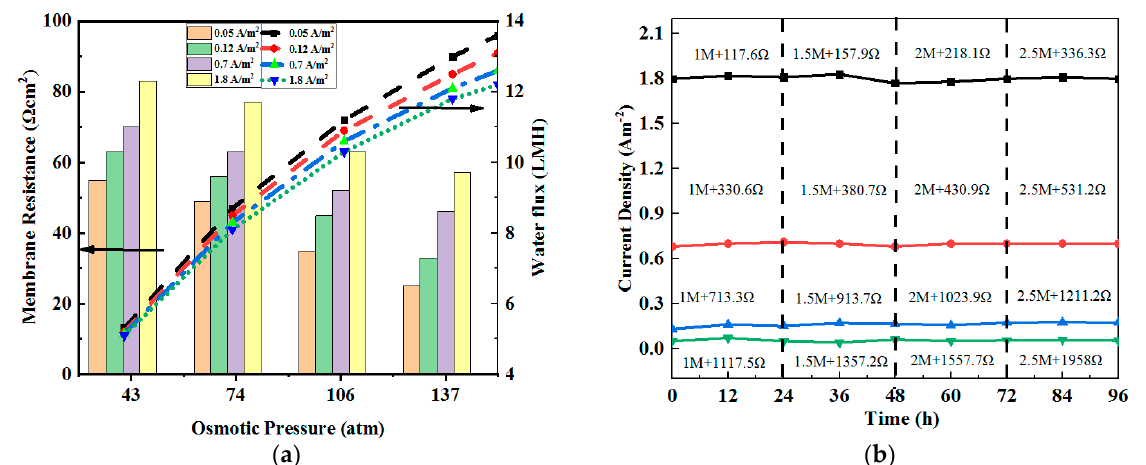
Figure 6. ( a ) Interaction between membrane impedance and current/water flux; ( b ) similar currents obtained under different conditions (catholyte concentration of 1 M NaCl + 117.6 Ω external re- sistance; ~2.5 M NaCl catholyte concentration + 2358 Ω external